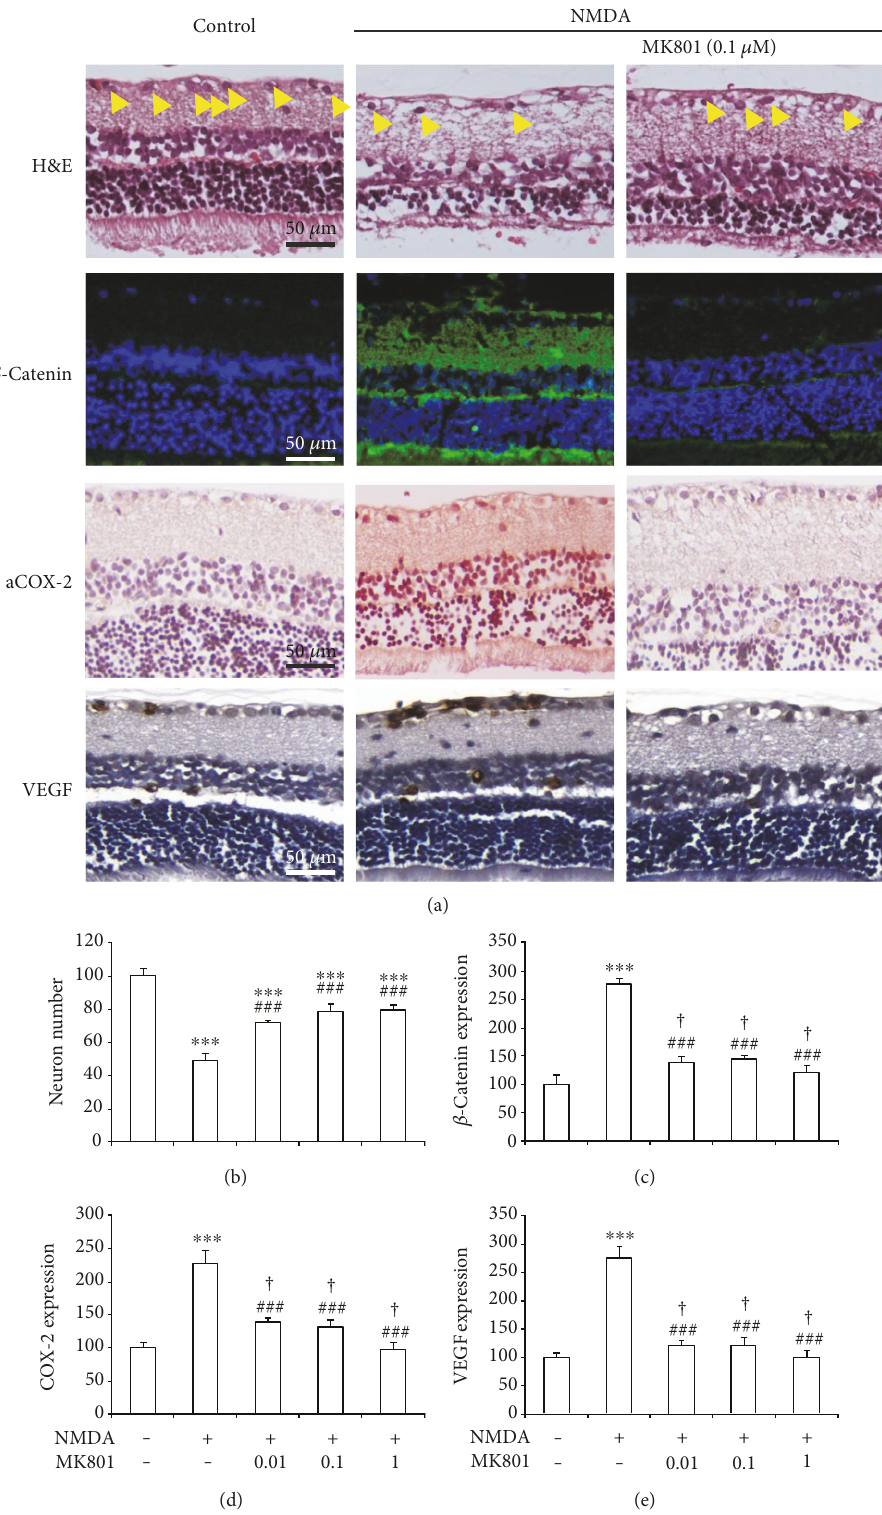
Figure 1: The protection of MK801 on retinal neuron cells in NMDA-treated rats. (a) Representative images (H&E staining, expression of β -catenin, COX-2, and VEGF) of the rats. (b) Neuron numbers of RGCs with respect to control (untreated), in NMDA-injected retinas of animals treated with MK801. (c) β -Catenin expression of retinas with respect to control in NMDA-injected retinas of animals treated with MK801. (d) COX-2 expression of retinas with respect to control in NMDA-injected retinas of animals treated with MK801. (e) VEGF expression of retinas with respect to control in NMDA-injected retinas of animals treated with